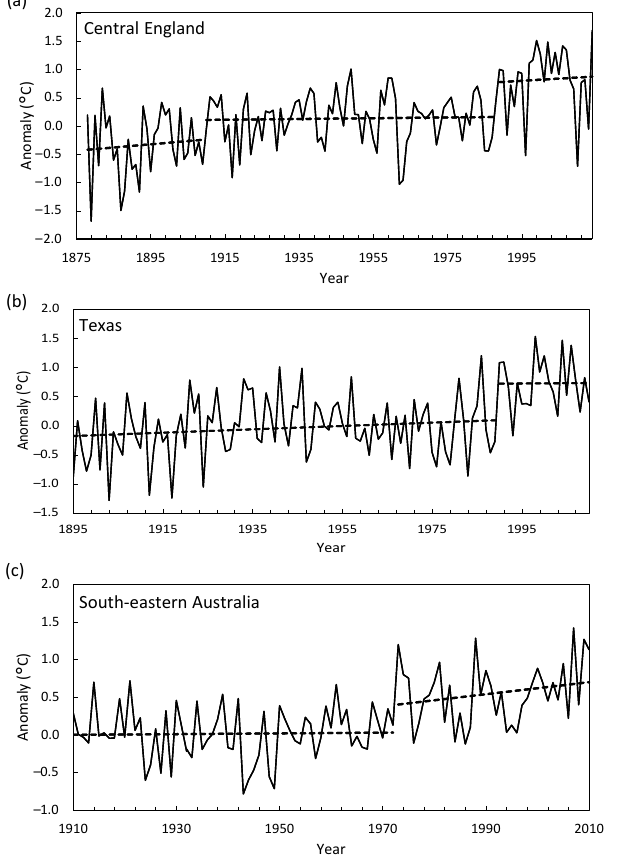
Figure 5. Anomalies of annual mean temperature attributed to non- linear changes where the influences of interannual variability have been removed for (a) central England, (b) Texas and (c) south- eastern Australia. Internal trends (dashed lines) are separated by step changes ( p